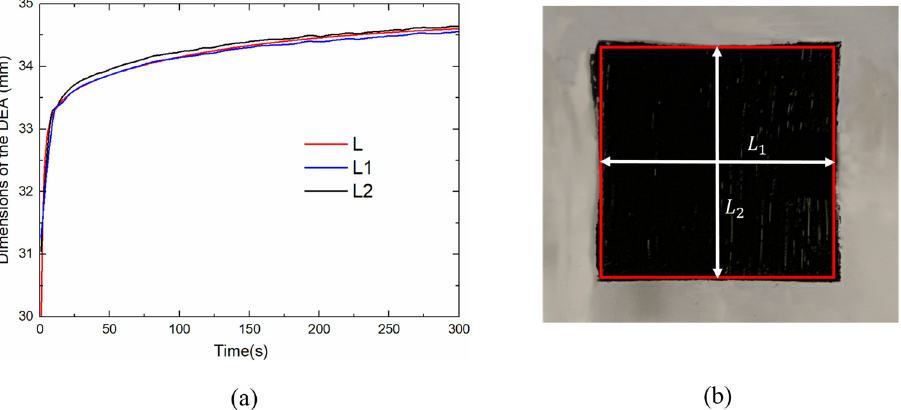
Figure 14. Experimental results of the DEA under two measurement methods: ( a ) The dynamic dimensions of two in-plane directions under U = 4kV voltage excitation, ( b ) Geometrical shape.